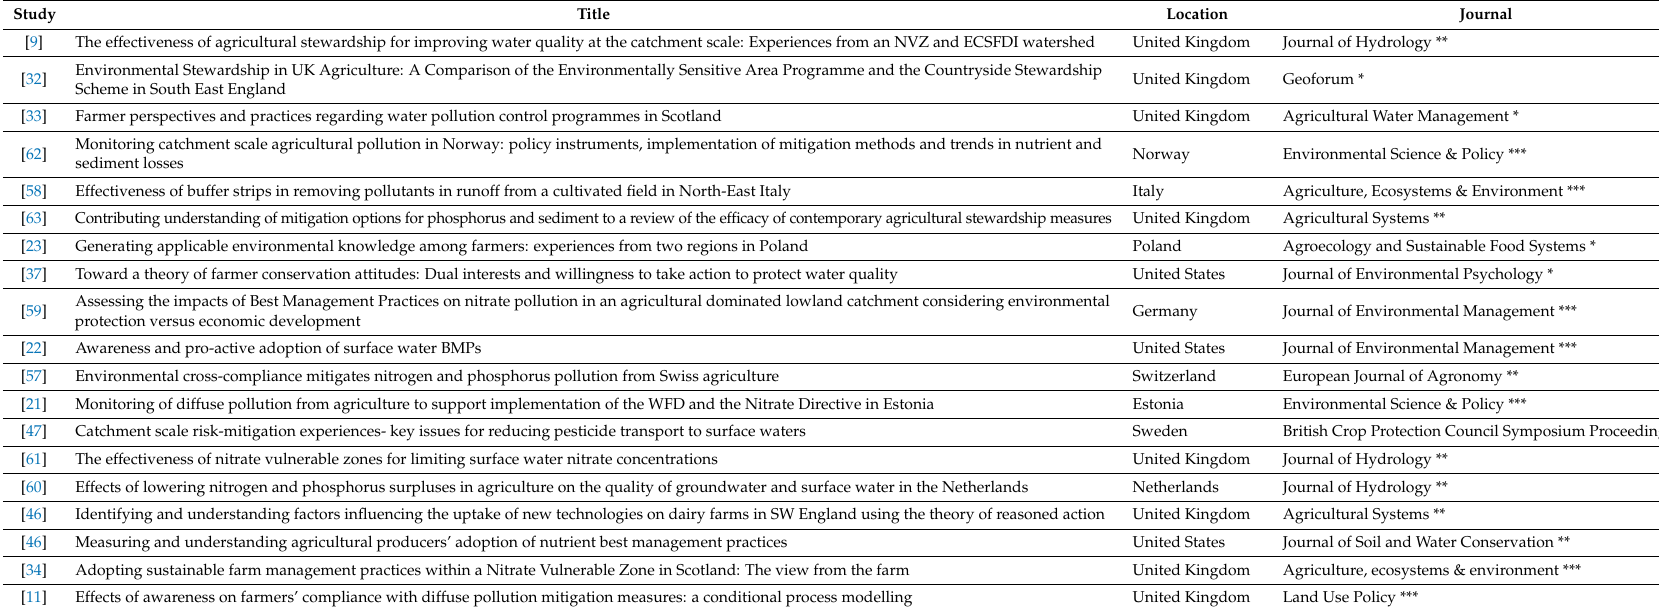
Table A1. List of Final Papers Used for the Evidence